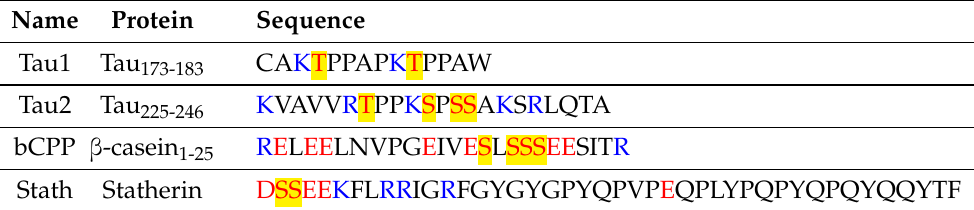
Table 1. Full name and sequence of the peptides included in this study. Positively charged residues are marked in blue, negatively charged in red, and phosphorylated residues highlighted with yellow. Note that Tau1 includes three additional residues in accordance with [11], to allow for experimental